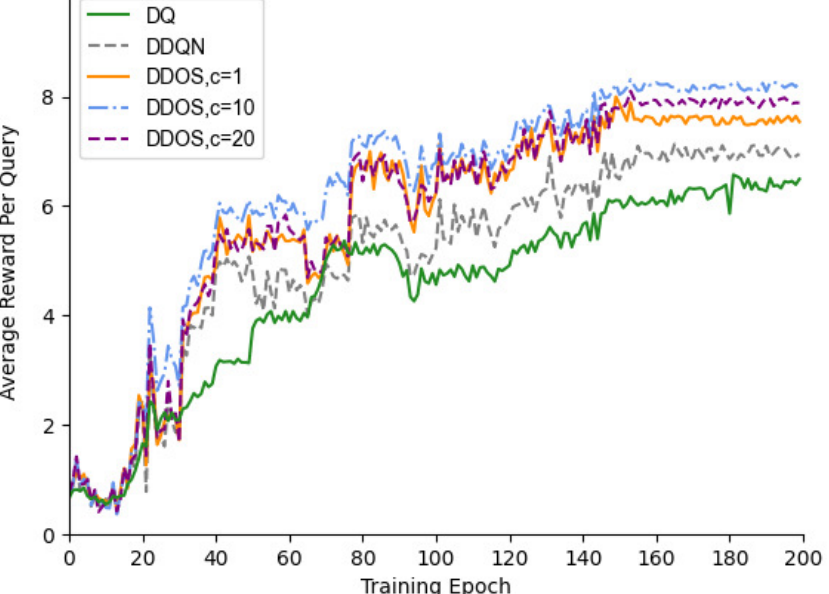
Figure 5. Comparison of the average reward value of DDQN and DDOS under different parameters (higher average reward value means a smaller and more reasonable query join